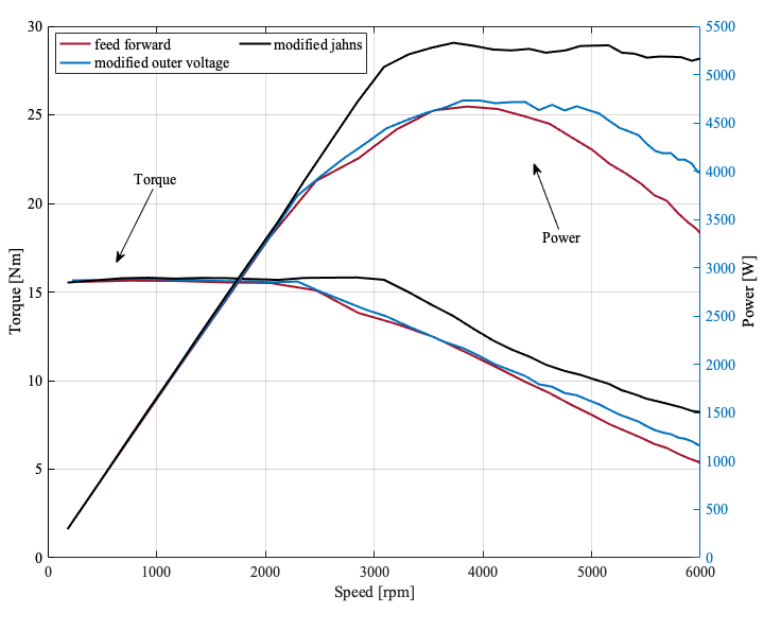
Figure 19. Comparison between the basic FF method and the proposed ones. FF (red line), enhanced outer voltage (blue line) and enhanced Jahns’ method (black line). Experimental